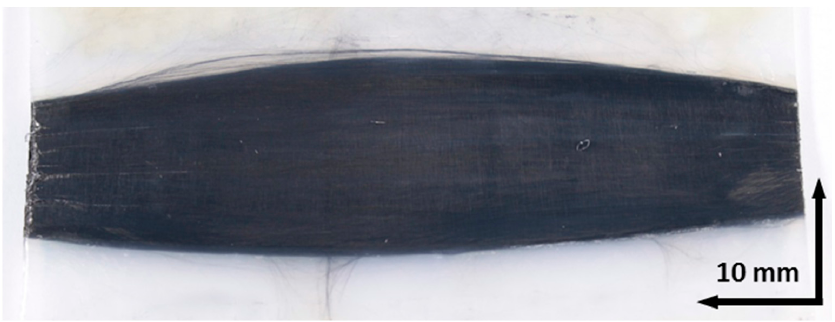
Figure 8. Ultrasonically fabricated CFRP sample made from 17 layers of carbon fibers and 18 layers of PA foils, all 100 µm in thickness. The total thickness of the CFRP was 1 mm.